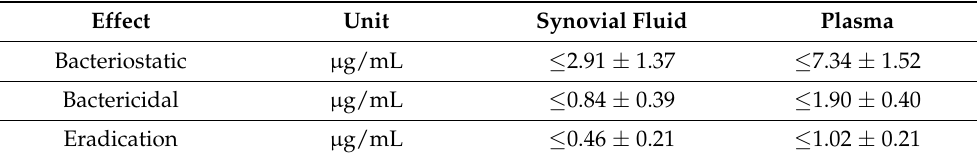
Table 3. Critical MIC values of florfenicol against S. suis regarding bacteriostatic, bactericidal and eradication effects in pig synovial fluid and